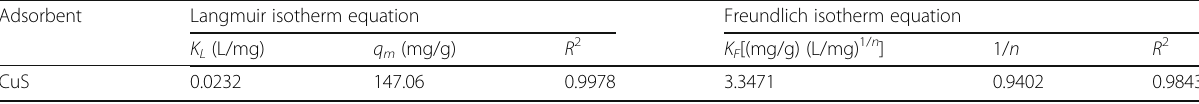
Table 2 Parameters of EE2 isothermal model for copper sulfide adsorption Adsorbent Langmuir isotherm